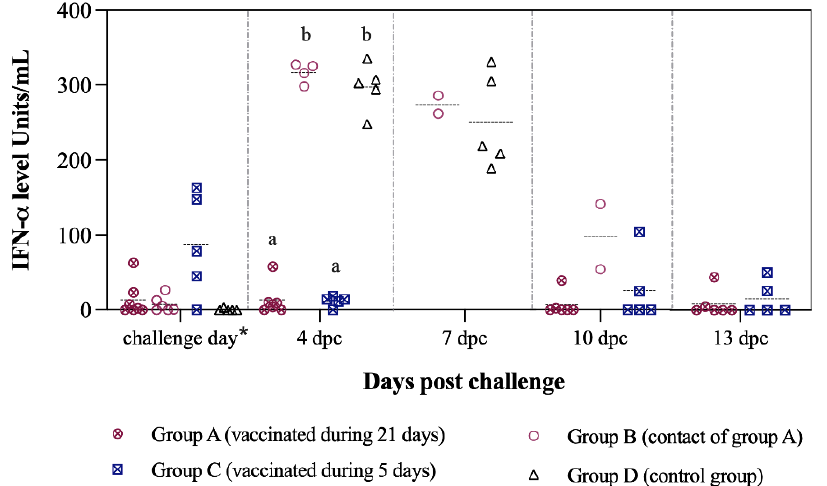
Figure 8. IFN- α levels in sera after challenge during 13 dpc. IFN- α levels were determined at different time points after challenge with CSFV “Margarita” strain. Asterisk symbol (*) refers to 21 dpv for group A and 5 dpv for group C. Letters above the symbols are used to represent statistically significant differences between the groups on that day: similar letters indicate no statistical difference, and different letters show statistical difference ( p < 0.05).